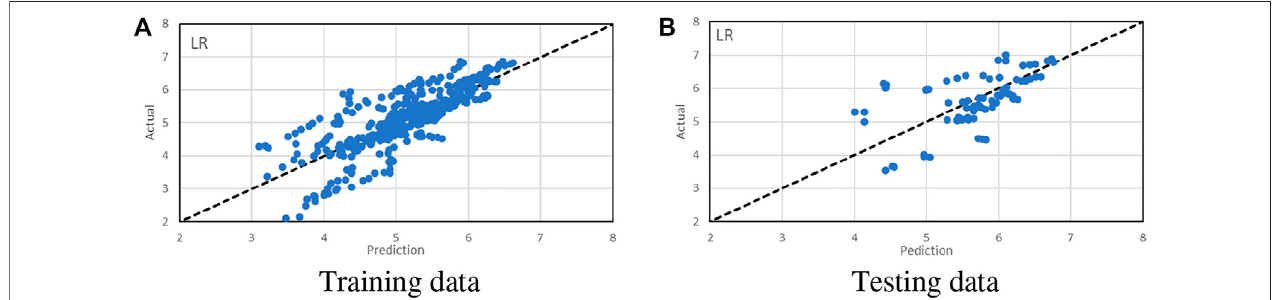
FIGURE 4 | Actual vs. prediction of Linear models comparison.